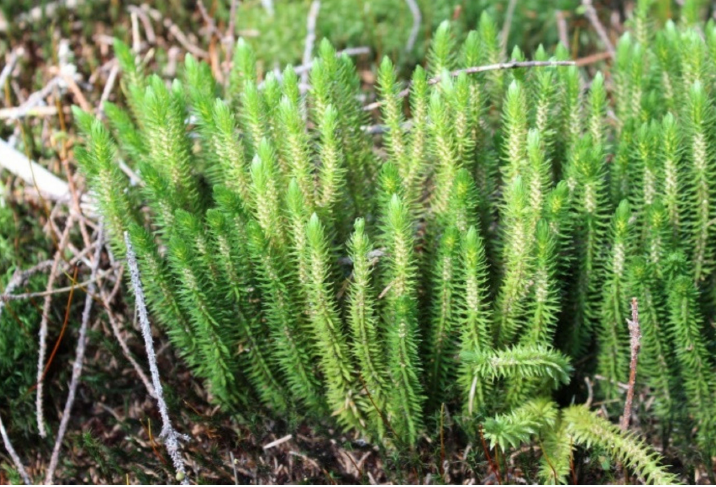
Figure 2. Lycopodim selago L. in Cluj County, Romania, 2020 (authors personal